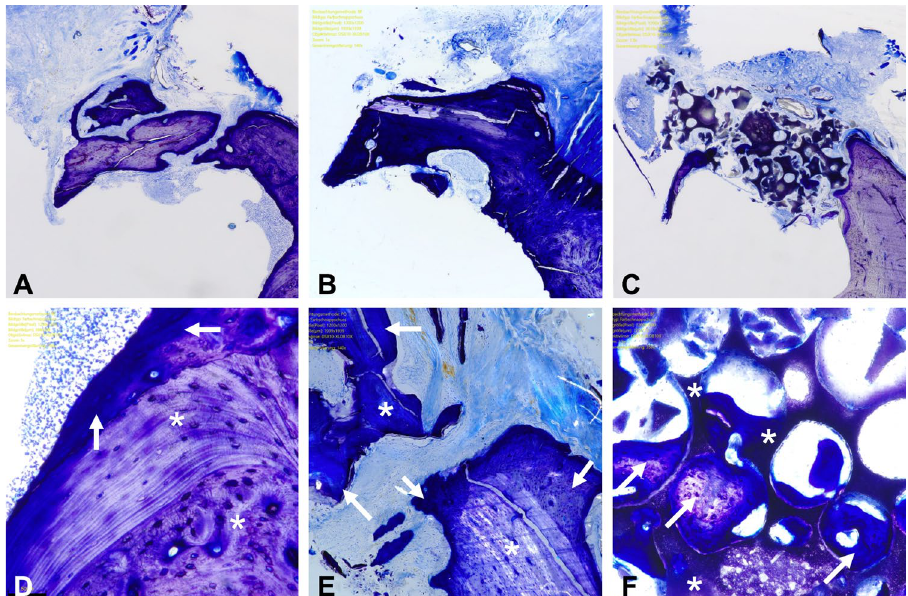
Figure 6. Histological cross-section (toluidine blue stains) through the reconstructed jaw 84 days after cleft repair using autologous bone ( A , D ), xenogeneic/human bone ( B , E ), and synthetic tricalcium phosphate/ hydroxyapatite bone substitute ( C , F ): overview: ( A – C ) × 100 magnification; detailed view: ( D – F ) up to × 350 magnification, persistent bone/substitute (*), new bone formation